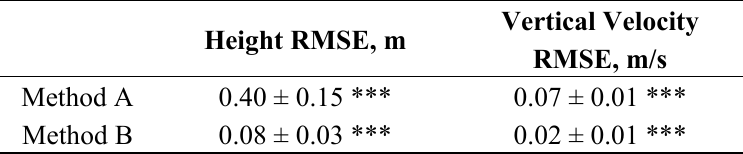
Table 2. RMSE statistics expressed as mean value ± standard deviation (SD) across N = 10 trials.